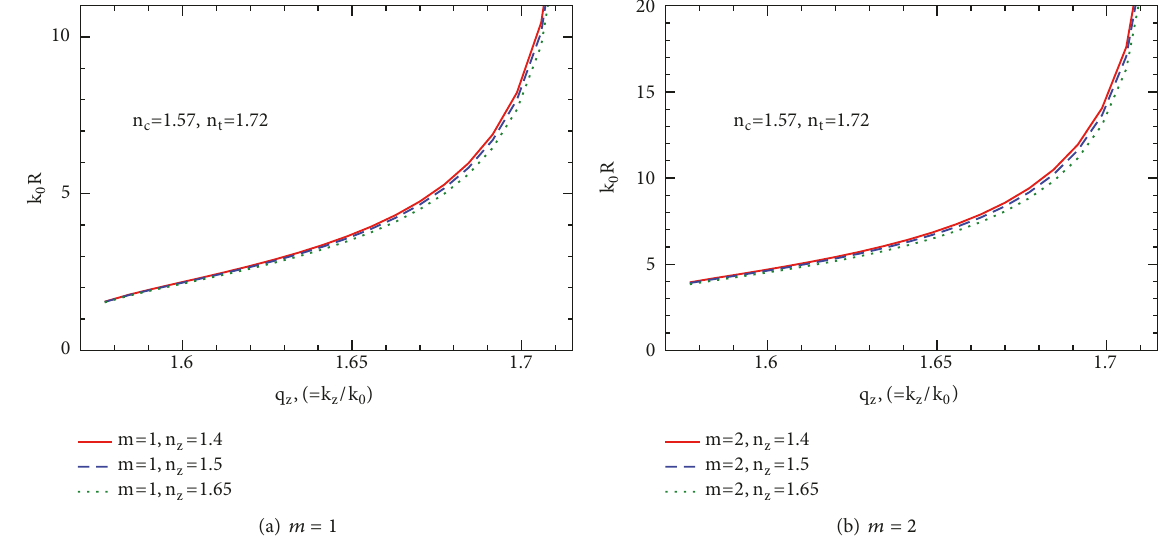
Figure 4: Dependence of the dimensionless parameter 𝑘 0 𝑅 ≡ 𝜔𝑅/𝑐 on 𝑞 𝑧 = 𝑘 𝑧 /𝑘 0 for the waves with (a) 𝑚 = 1 and (b) 𝑚 = 2 at different values of the refractive index 𝑛 𝑧